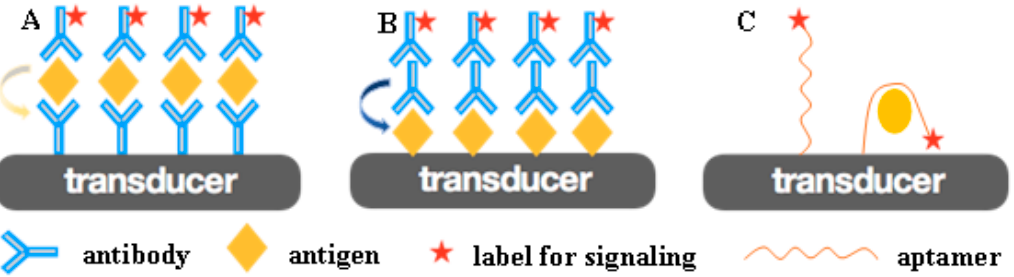
Figure 1. ( A ) The antibody works as an MRE to recognize and capture the specific antigen in sandwich-mode immunosensing. ( B ) Antigen works as an MRE to recognize and capture the specific antibody in sandwich-mode immunosensing. ( C ) Aptamer works as an MRE to recognize and capture the specific protein.